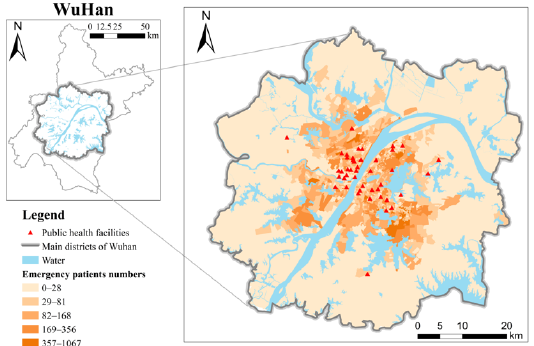
Figure 1. The metropolitan development zone (MDZ) of Wuhan.